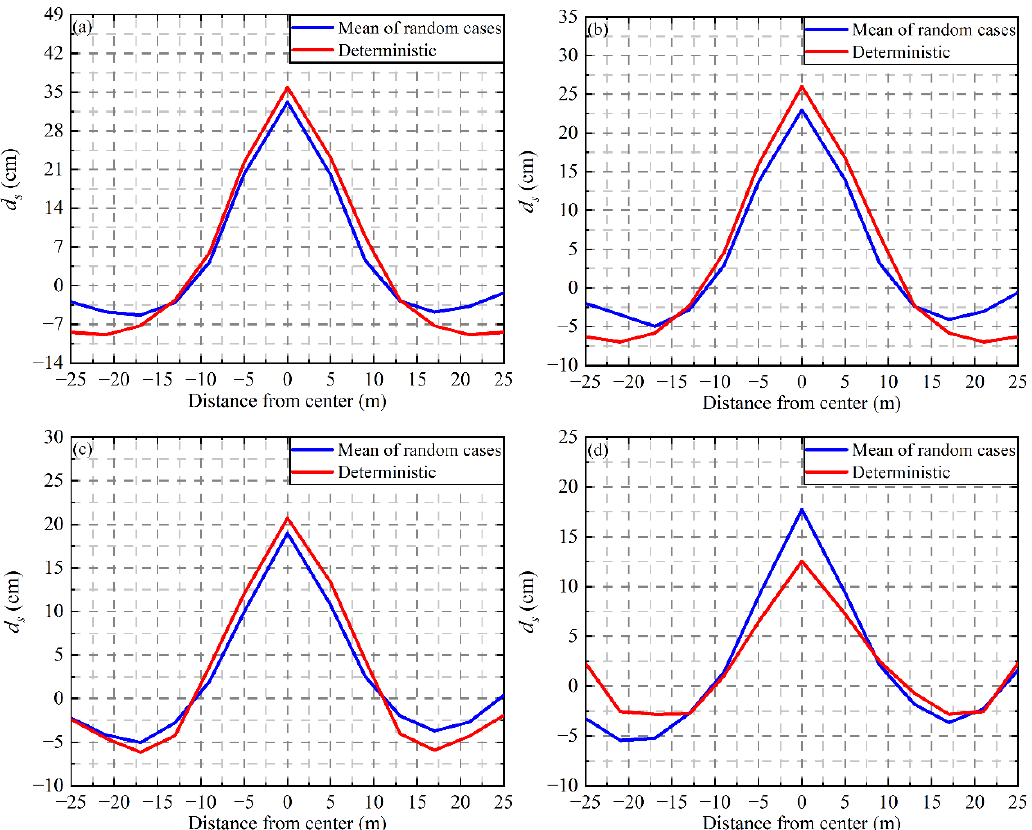
Figure 20. Comparison of vertical displacements at each position of the ground under different embedment depths: ( a ) H = 6 m; ( b ) H = 8 m; ( c ) H = 10 m; ( d ) H = 12 m.